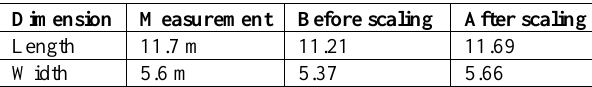
Table 1: Measurements made on the slave cabin point cloud.